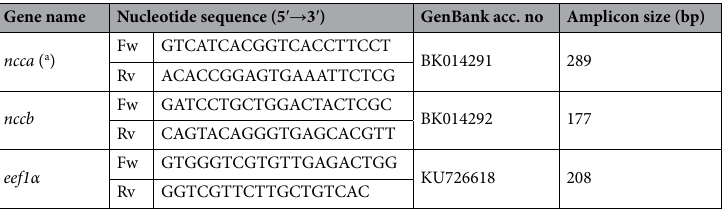
Table 1. Primers used for real-time qPCR expression analysis. GenBank accession number referred to the unique sequence identifier in the gene assembly and sizes of the amplified products (bp). a Primers from 57